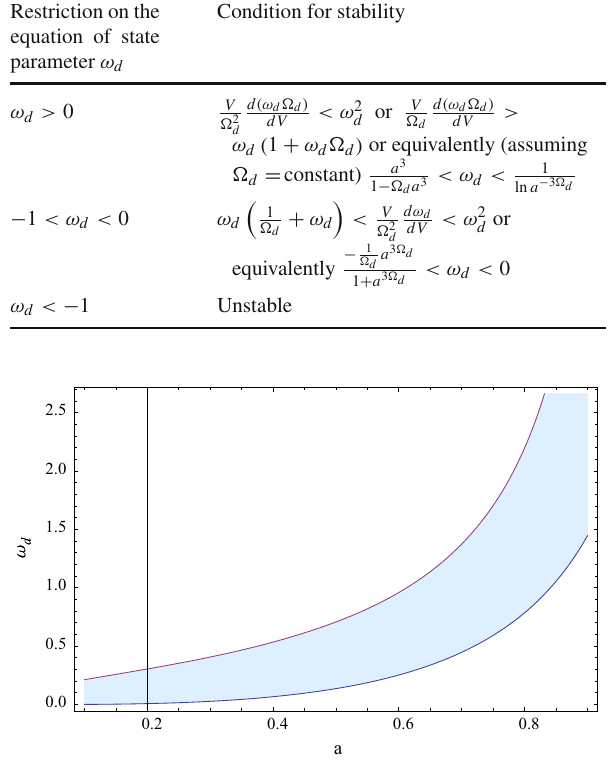
Fig. 1 The shaded region shows the valid region for ω d (> 0 ) under stability criteria for (cid:6) d = 0 . 68